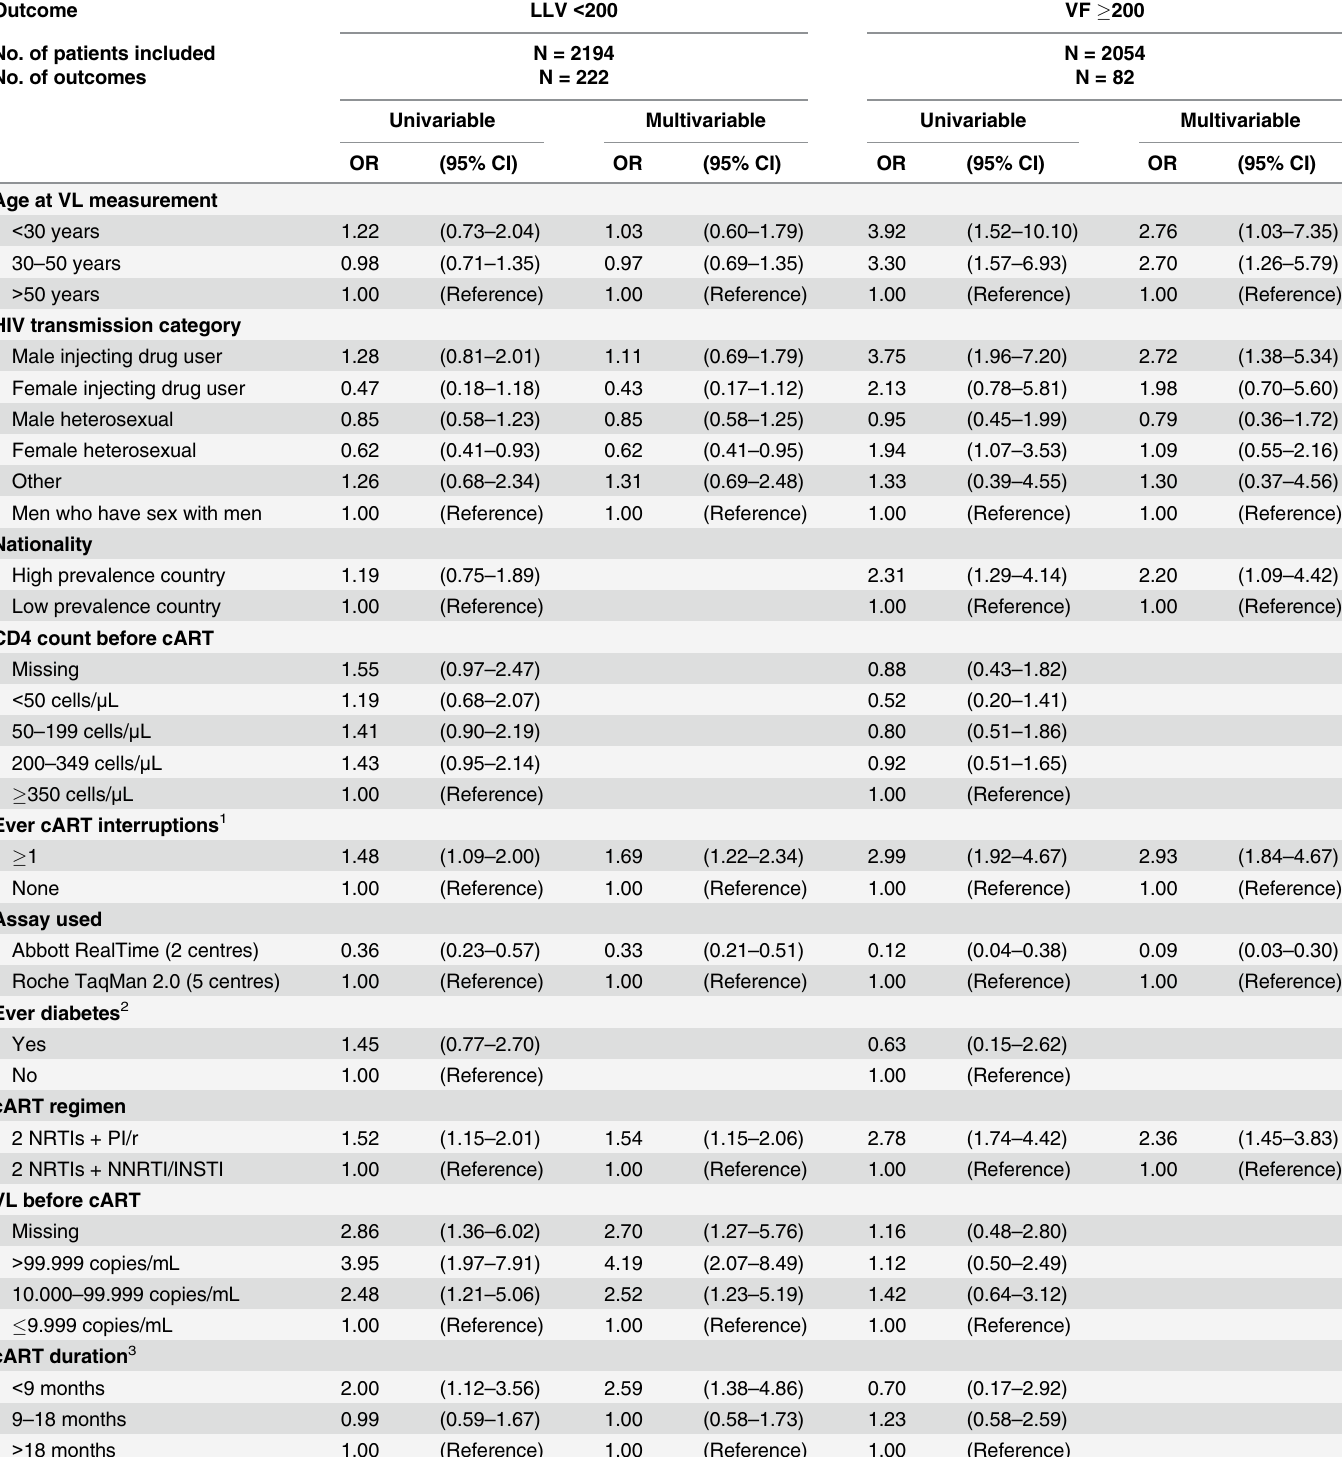
Table 2. Univariable and multivariable logistic regression results: Association between different factors and low-level viraemia as well as virologi- cal failure compared to HIV RNA levels below the limit of quantification.